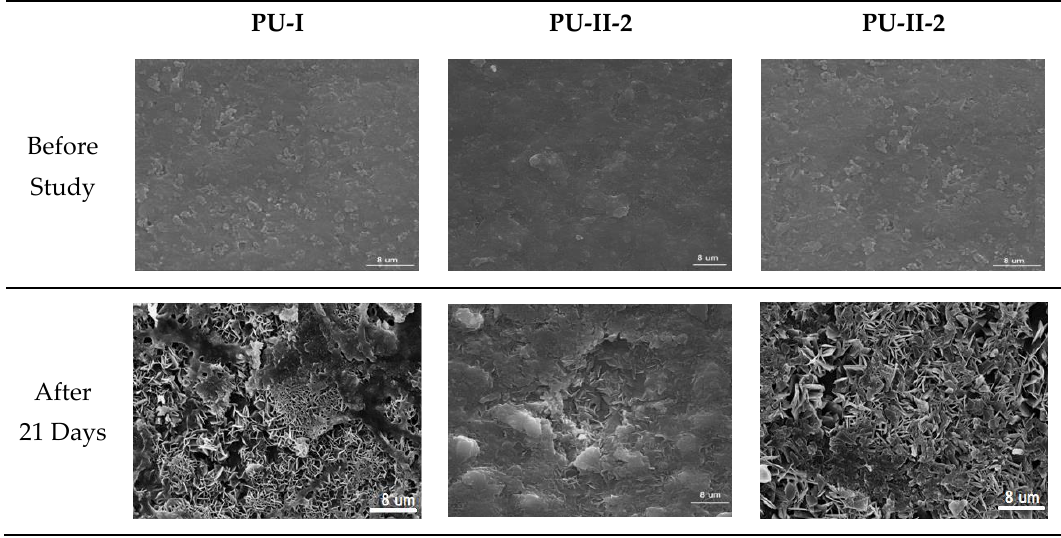
Figure 7. Selected SEM images of non-crosslinked (PU-I) and PVA-crosslinked (PU-II-1, PU-II-2) before and after calcification study.